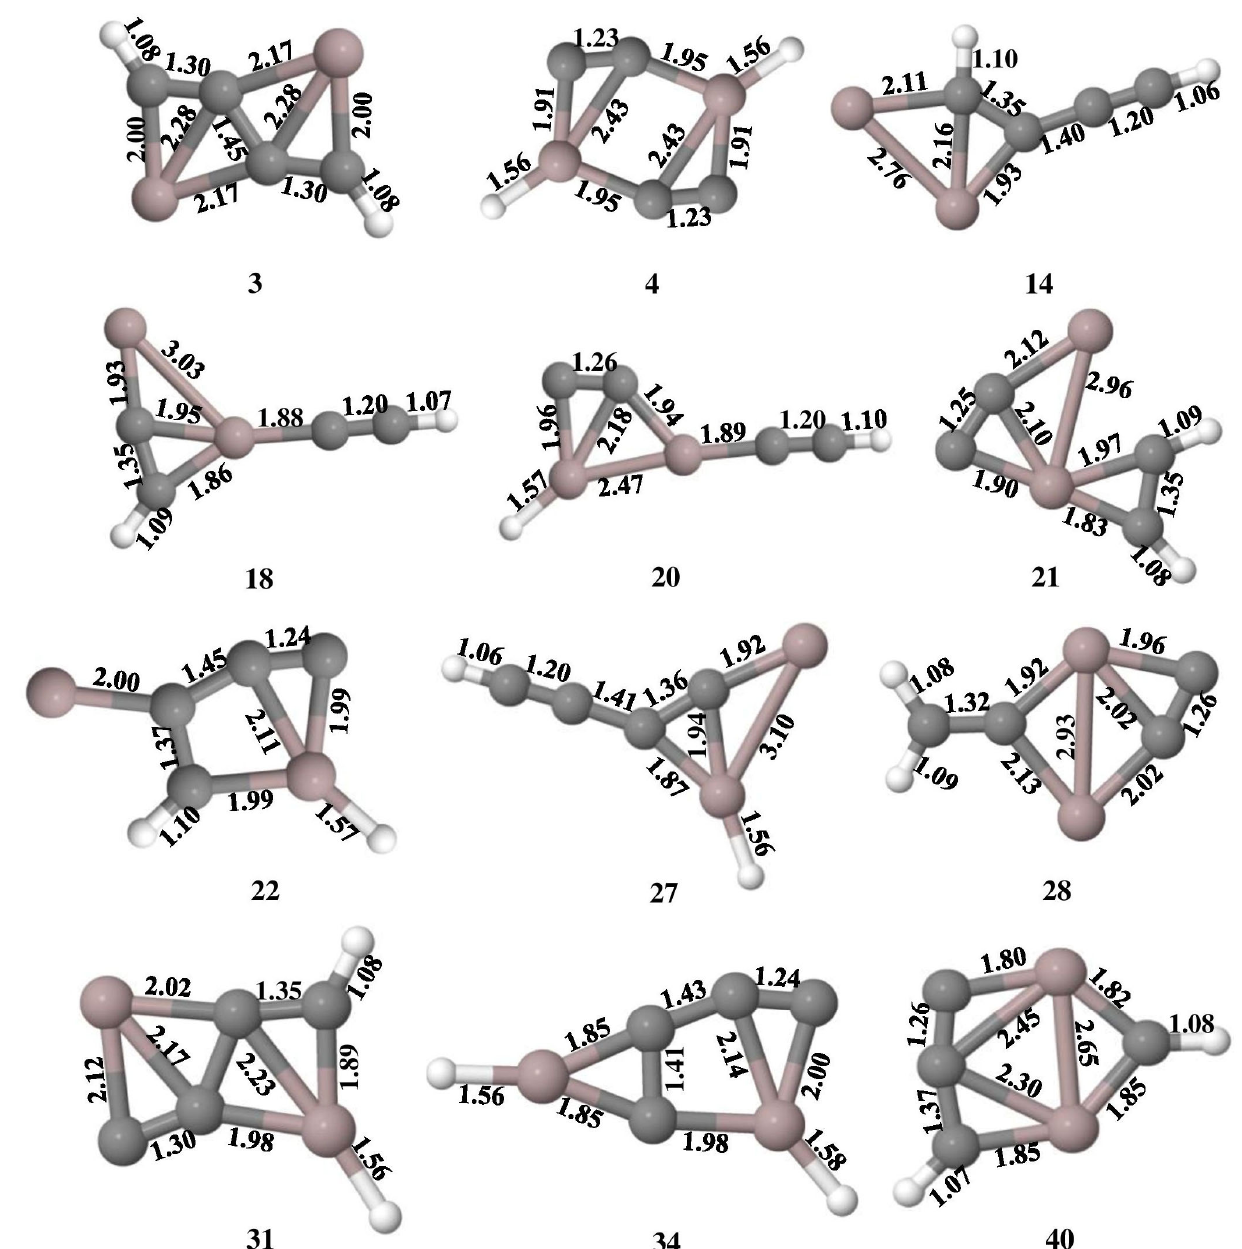
Figure 2. Isomers of Al 2 C 4 H 2 with the planar tetracoordinate carbon (ptC)/aluminum (ptAl) and planar pentacoordinate aluminum (ppAl) with their bond lengths in Å obtained at the ω B97XD/6-311++G(2d,2p) level of theory.